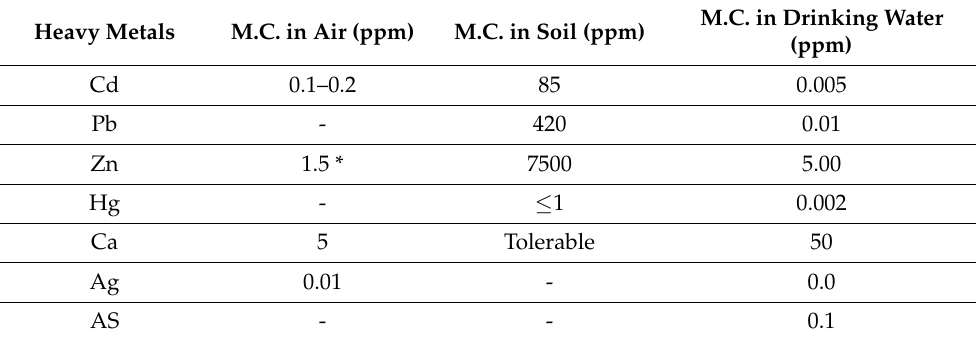
Table 1. American environmental protection agency, heavy metals levels [7]. Heavy